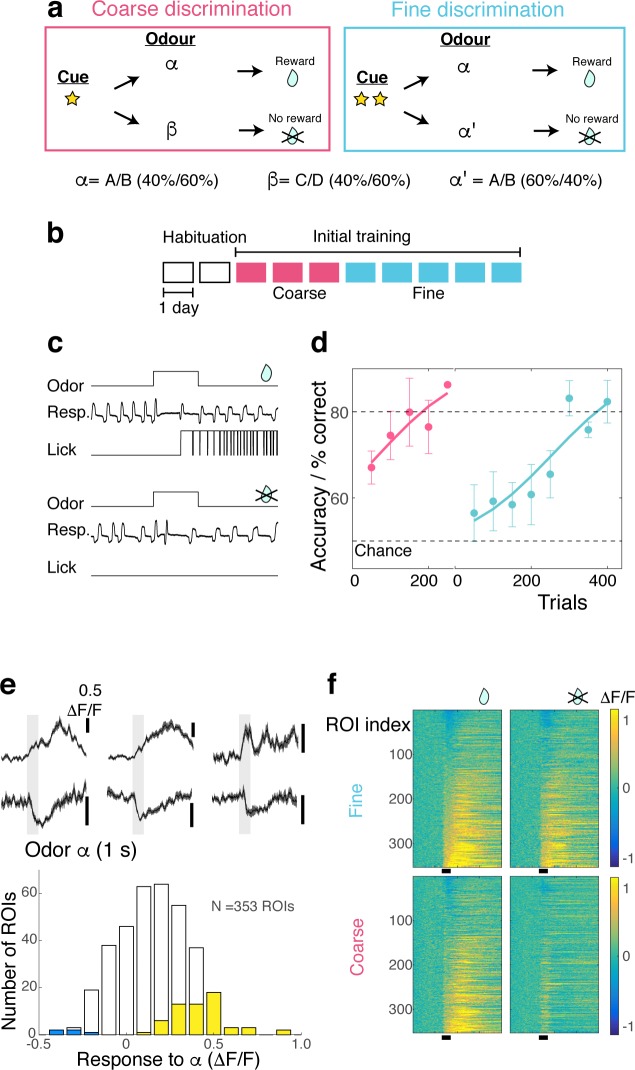
Method for imposing different behavioural task demands.(A) Structure of discrimination tasks. Right, Fine discrimination. A trial starts with two flashes of an LED. The rewarded stimulus (α) is a mixture of A and B odours at a concentration ratio of 40:60% (α-odour), associated with a water reward. In a non-rewarded trial, the A/B mixture at a concentration ratio of 60:40% (α’-odour) is presented, but no reward is given. Left, Coarse discrimination. A trial starts with one flash of an LED. The rewarded odour is the same as in fine discrimination. A non-rewarded stimulus is a mixture of different odours (β). In some rewarded trials, α’ odour is presented to assess whether mice generalize across both A/B mixtures. (B) Schematic showing timeline of initial training before mice were subjected to switch training. Each box represents one session, which occurred once a day. Following two days of habituation, mice went through on average three sessions of coarse discrimination training and five sessions of fine discrimination training. (C) Examples of correct behavioural responses for rewarded trials (top; correct hit) and for non-rewarded trials (bottom; correct rejection). An odour is presented for 1 s. and a reward is delivered 3 s after onset of the odour. (D) Learning rates for head-fixed mice used in the experiment (n = 5 mice) corresponding to initial training days as in (B). Mean and s.e.m. shown. (E) Above. Examples of excitatory and inhibitory responses evoked by S+ odour (gray bar, 1 s). Below. The distribution of responses evoked by S+ odour. Yellow and blue bars = significantly excitatory and inhibitory responses, respectively (see Materials and methods under ‘Odour response’). Scale bar, 0.5 ΔF/F. (F) Calcium transients as color maps in response to rewarded (left) and non-rewarded (right) odours for the tasks indicated. ROIs are sorted by the S+ response amplitude. n = 353 ROIs, five mice.